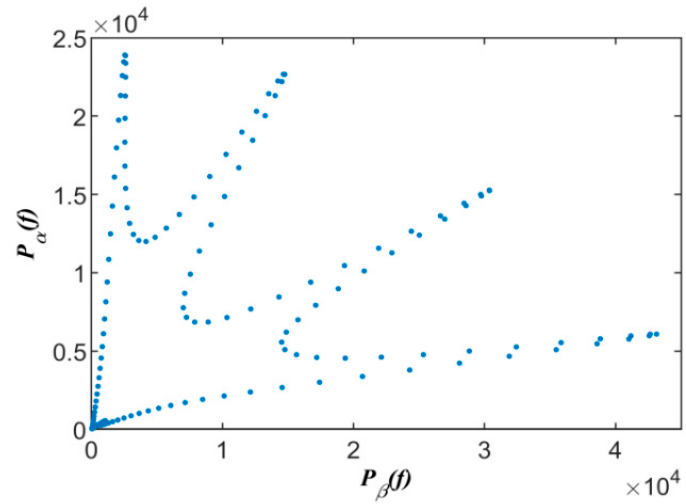
Figure 1. The power scatters of mixed signals without TF aliasing.